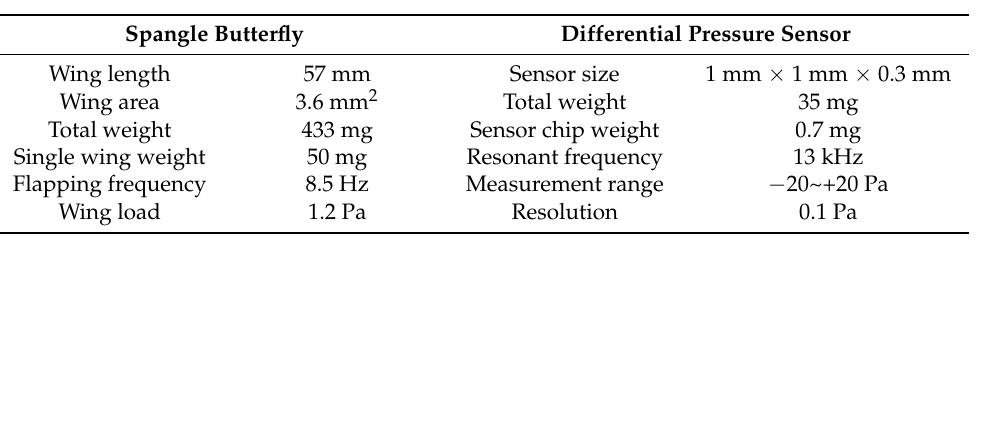
Table 3. Characteristics of the butterfly specimen and differential pressure